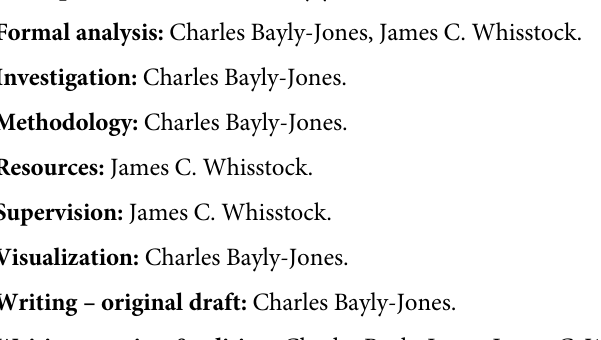
S1 Fig. Select examples of newly identified PFPs. a. Identified MACPFs from slime mold and zebrafish. b. Various β -PFPs with aerolysin-like pore-forming domains which resemble aerolysin, lysenin, epsilon toxin, monalysin and LSL. Observed in numerous organisms including drosophila, C . elegans , zebrafish, yeast, among others. c. Several novel α -haemoly- sin-like proteins identified in S . aureus and plants. The putative receptor binding domain is coloured green and the pore-forming domain is coloured grey with the expected transmem- brane region in red. S1 Table. Curated lists of pore-forming proteins identified by DALI search of AlphaFold database, organised by query. S2 Table. Ranked list of structurally-assigned pfam matches against the S . aureus foldome. (XLSX) S1 Text. Definition of a “foldome”.